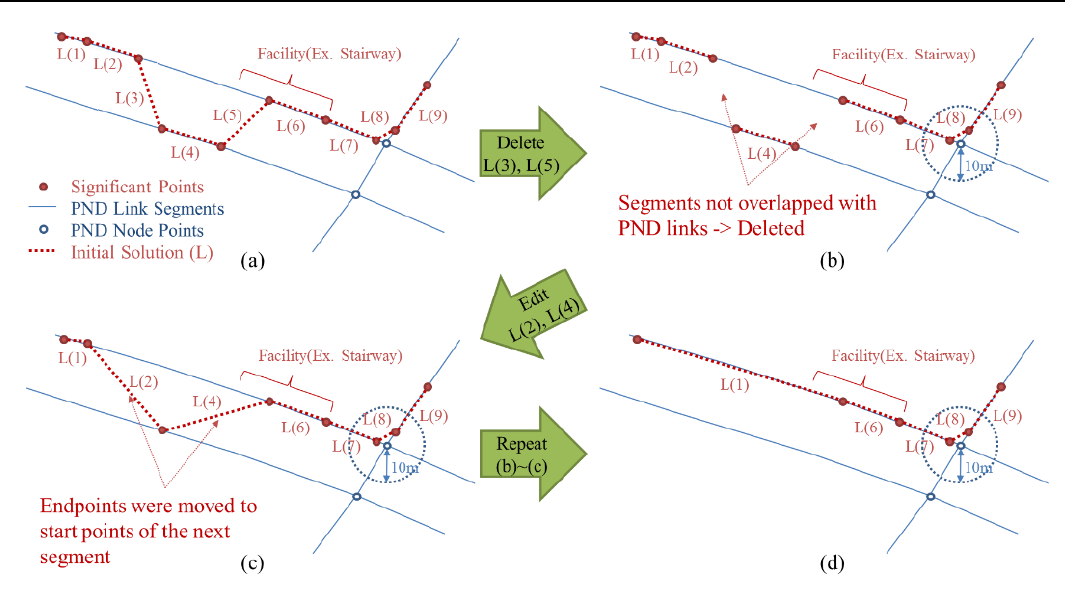
Figure 5. Process for correcting errors on dual-lined segments: ( a ) Initial solution after the initial matching; ( b ) Segments not overlapped with PND are deleted; ( c ) Endpoints of the initial solutions are moved to start points of the next segments; ( d ) Repeat ( a – c ) until there is no more segment